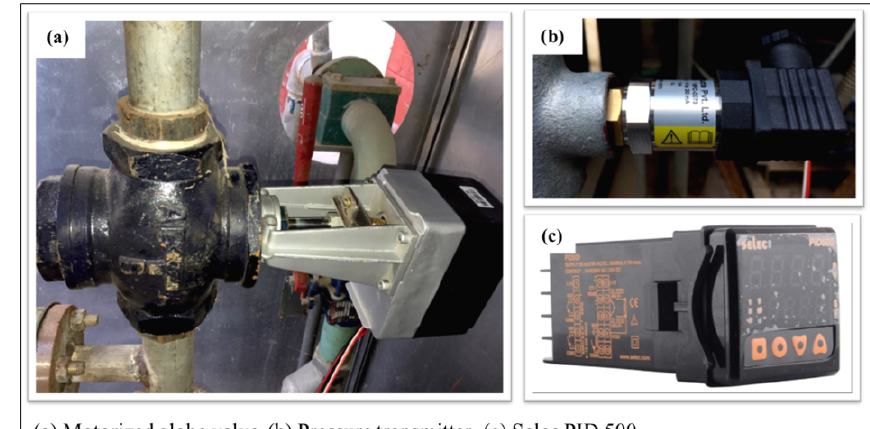
Figure 6. Components used for pressure-regulating